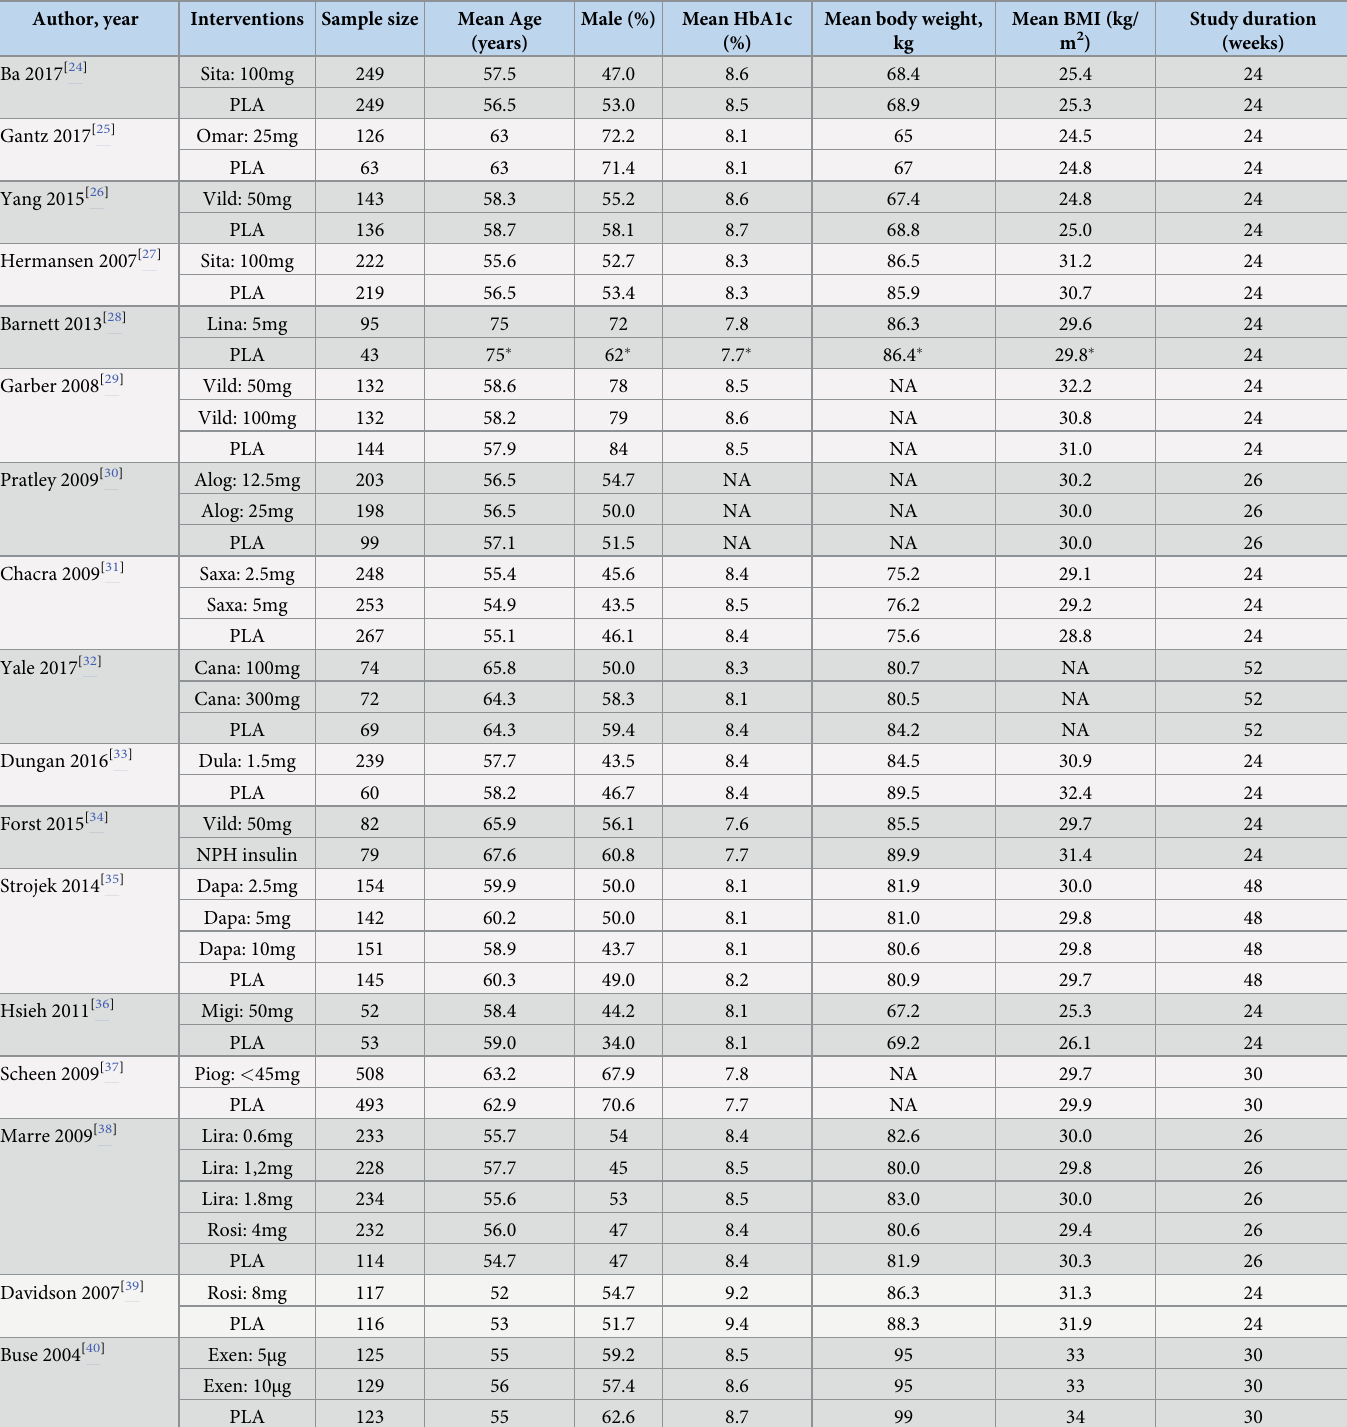
Table 1. Characteristics of the included